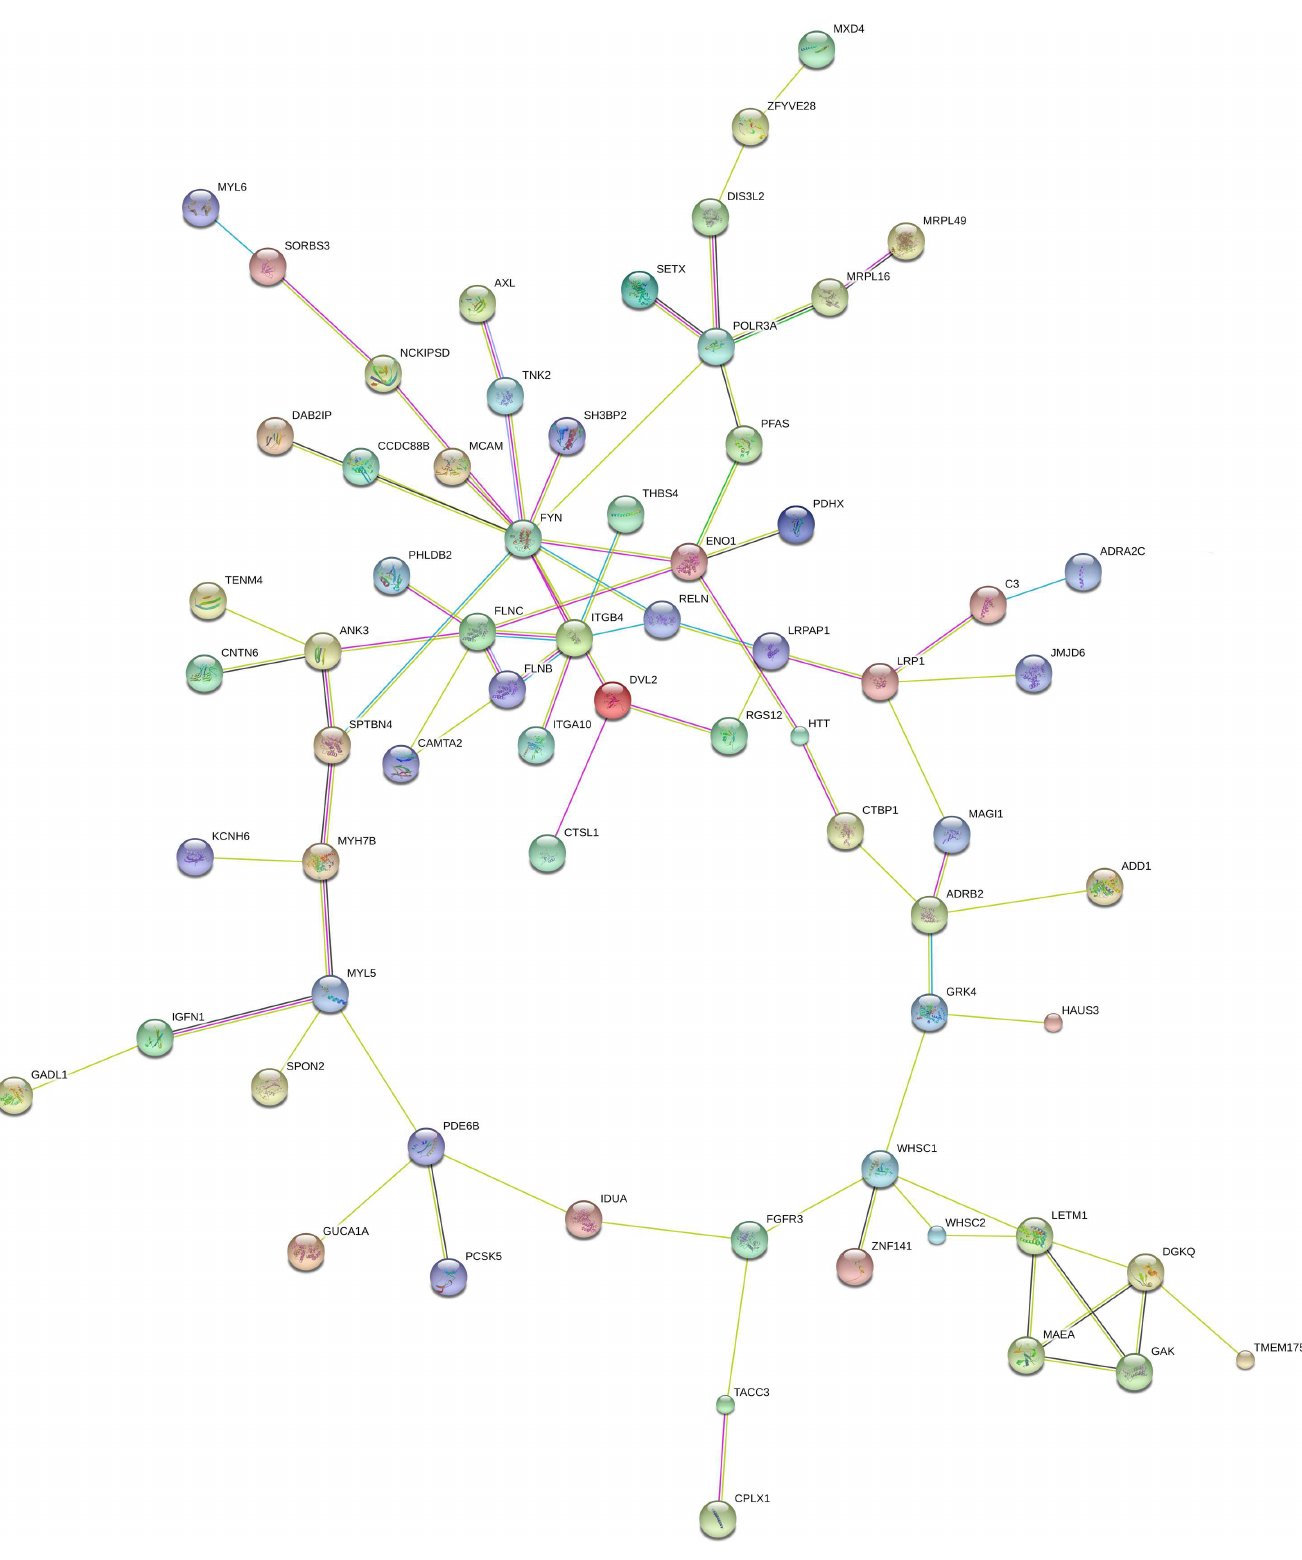
Fig 5. Female sibling STRING network analysis. Biggest componentof the connectingbrain-expressed genespresent in the unbalanced translocation, altered by the sharedand exclusiverare inheritedSNV and indelsfound in the female sibling.